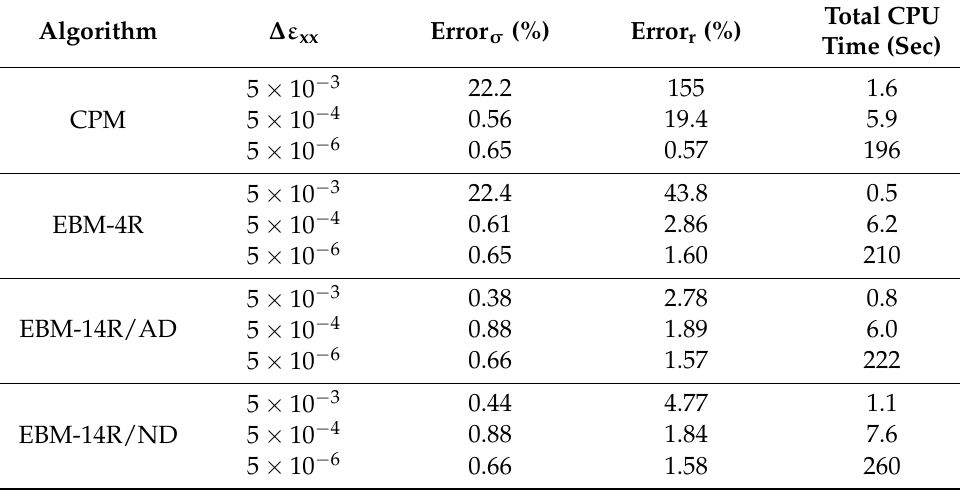
Table 6. Average relative errors in the flow curves and r-values of MAT 2 under